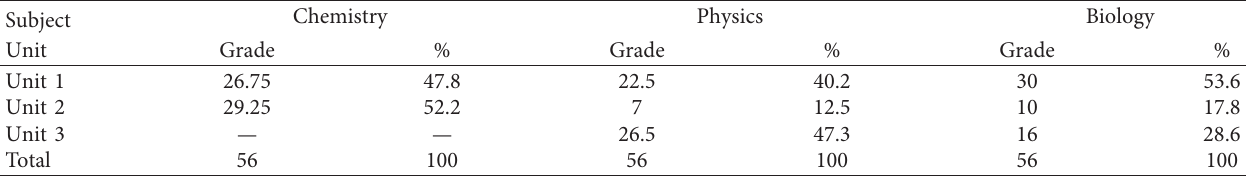
Table 13: Distribution of final examinations questions’ scores for the second period of the academic year 2018-2019, its frequencies, and percentages according to its importance for each unit in the textbook.